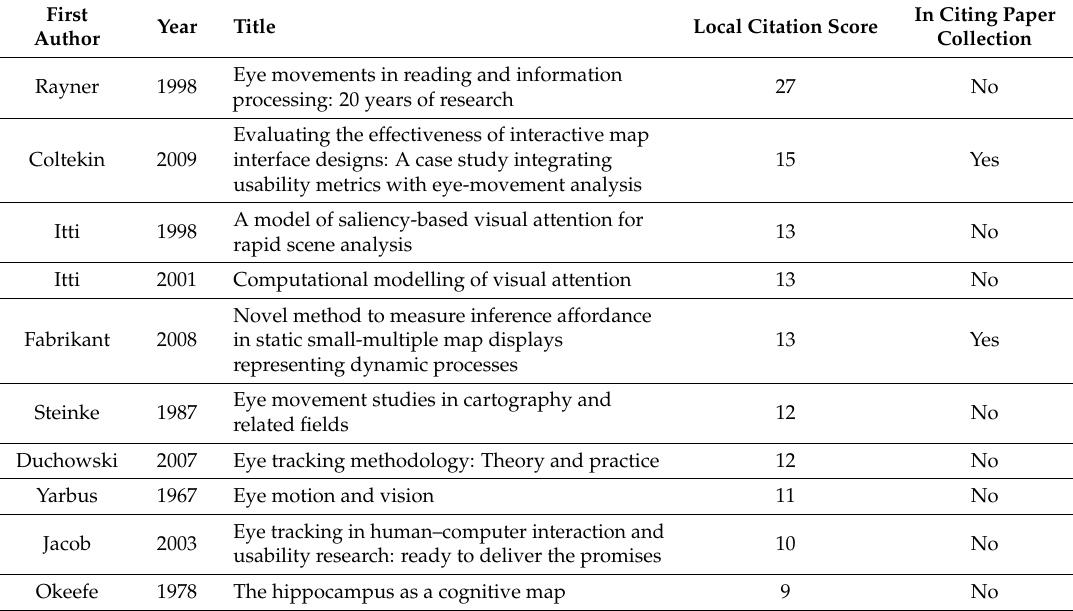
Figure 3. Classic works displayed using the time zone view. Table 1. Top 10 classic literature identified using co-citation analysis.